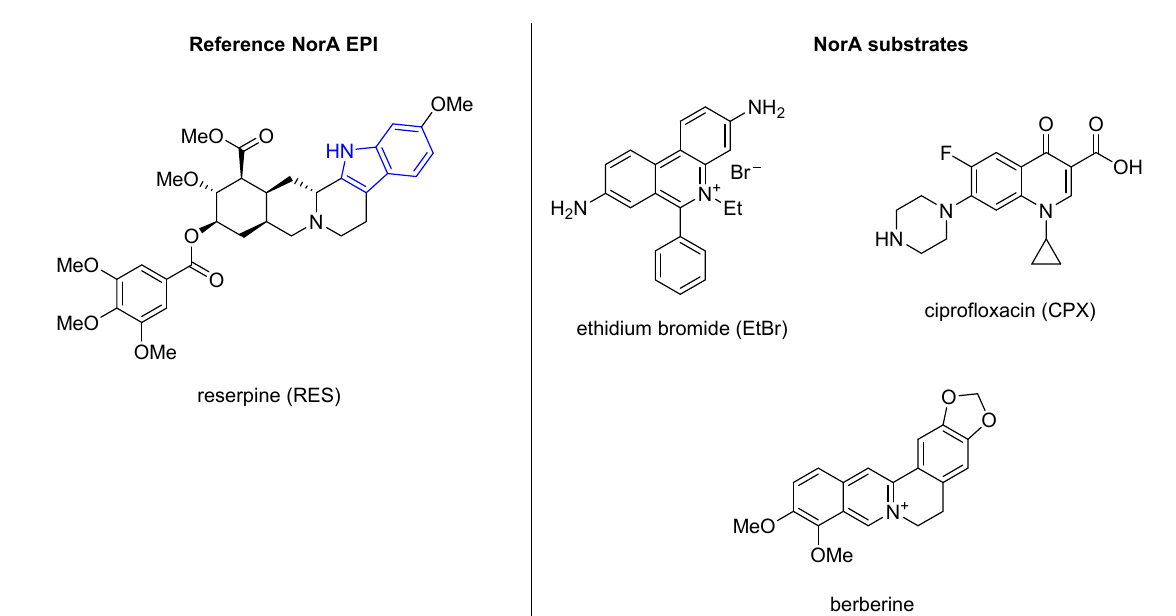
Figure 1. Reference NorA EPI reserpine ( RES ) and NorA substrates ethidium bromide ( EtBr ), ciprofloxacin ( CPX ) and berberine. Blue color is used to highlight the indole portion present in reserpine.